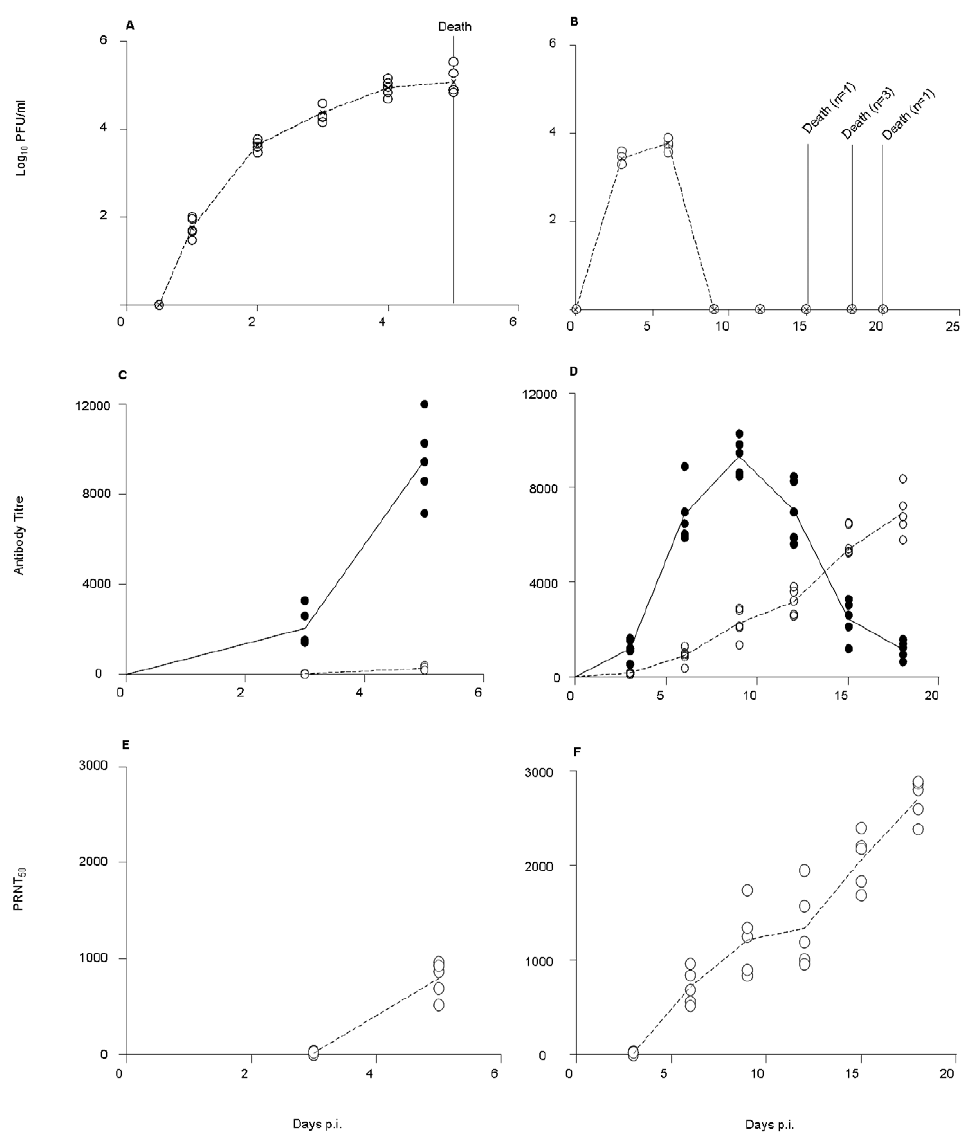
Figure 3. Viremia and antibody titres in D2Y98P-infected mice. Mice were ip. infected with 10 7 (A, C, E) or 10 4 (B, D, F) PFU of D2Y98P. At the indicated time points, five infected animals were bled and euthanized immediately. Viremia titres (A, B), specific anti-IgM (black circle) and IgG (open circle) titers (C, D), and PRNT 50 (E, F) were determined for each individual serum. Results are representative of 2 independent experiments.